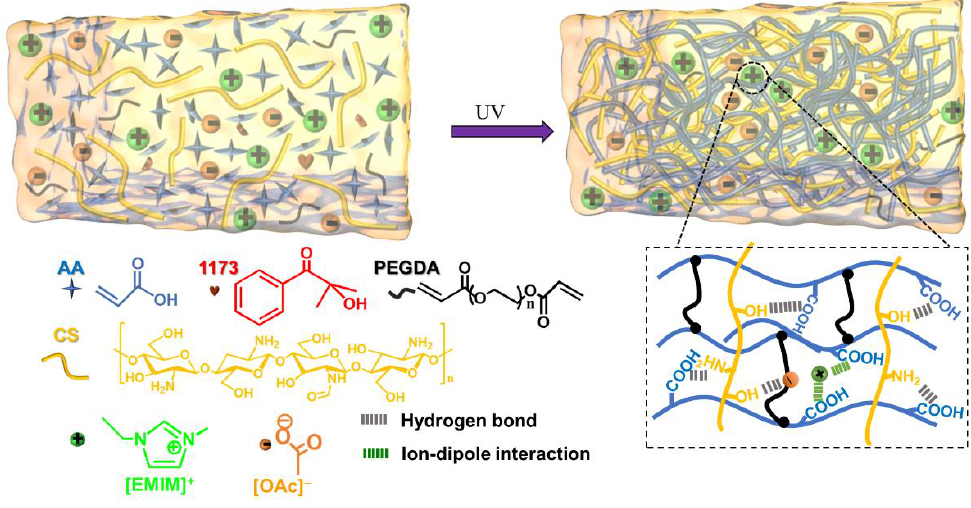
Scheme 1. Schematic diagram of the preparation of CS/PAA DN